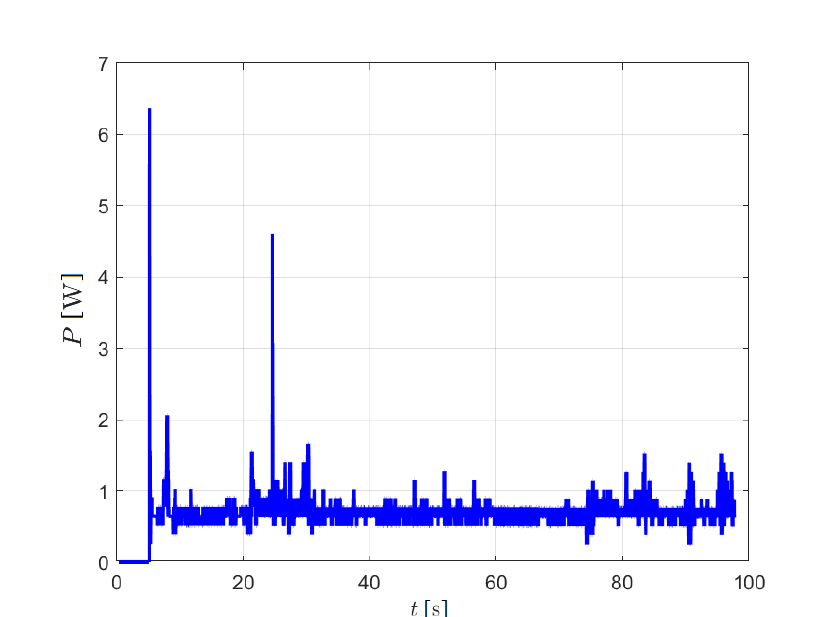
Figure 44. Power P during Map 3 run for the HybridA star algorithm of the